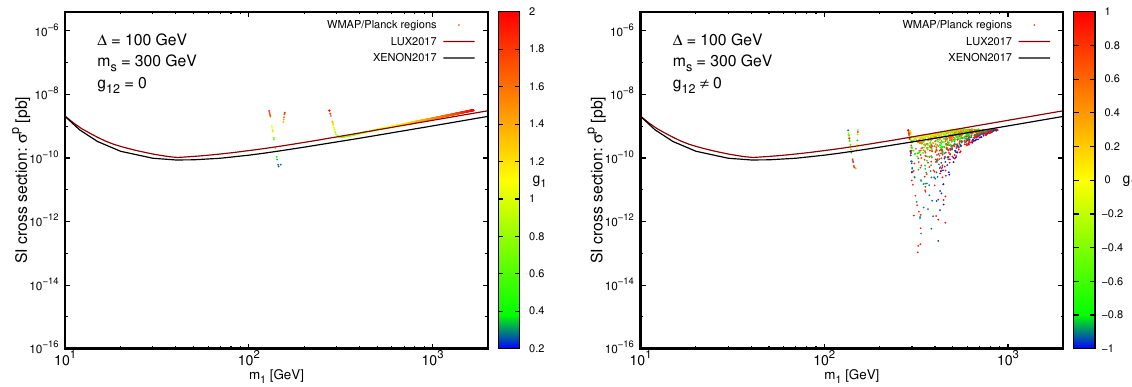
Figure 4 . The DM-proton (SI) scattering cross section as a function of DM mass for the mass splitting (cid:1) = 100 GeV and singlet scalar mass m s = 300 GeV. In the left panel g 12 = 0 and in the right panel g 12 6 = 0. The mixing angle is (cid:12)xed at sin (cid:18) = 0 :